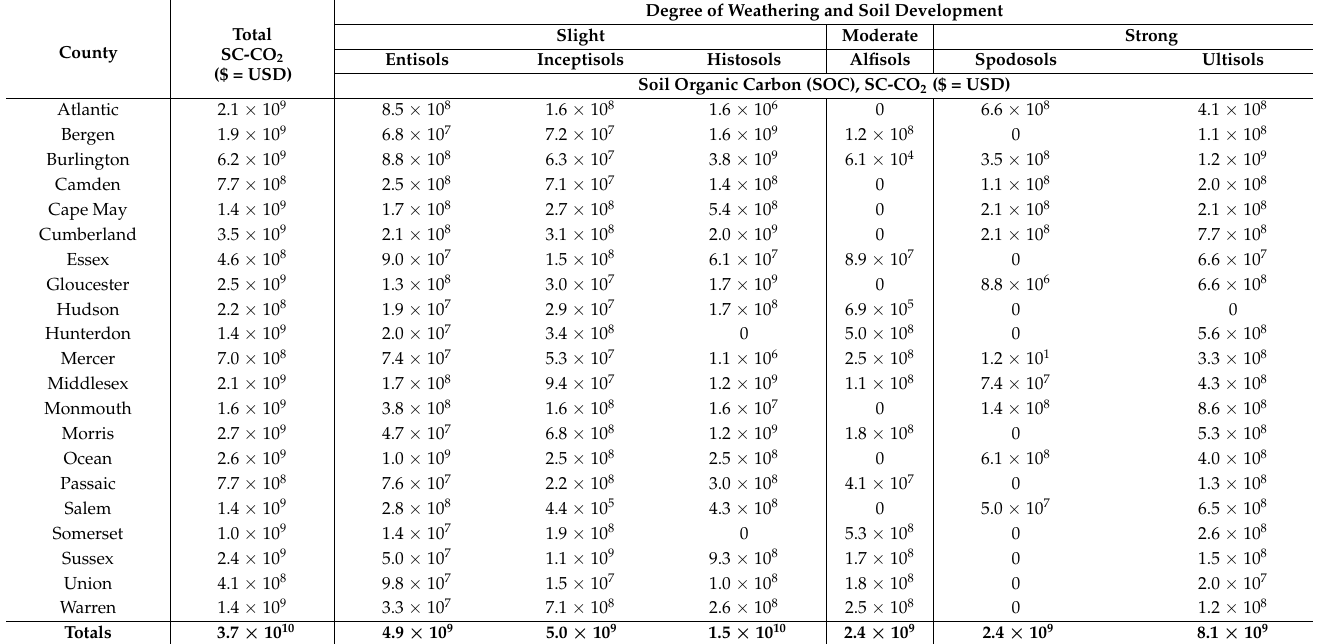
Table 5. Midpoint monetary values of soil organic carbon (SOC) by soil order and county for the state of New Jersey (USA), based on the areas shown in Table 3 and the area-normalized midpoint monetary values in Table 4.